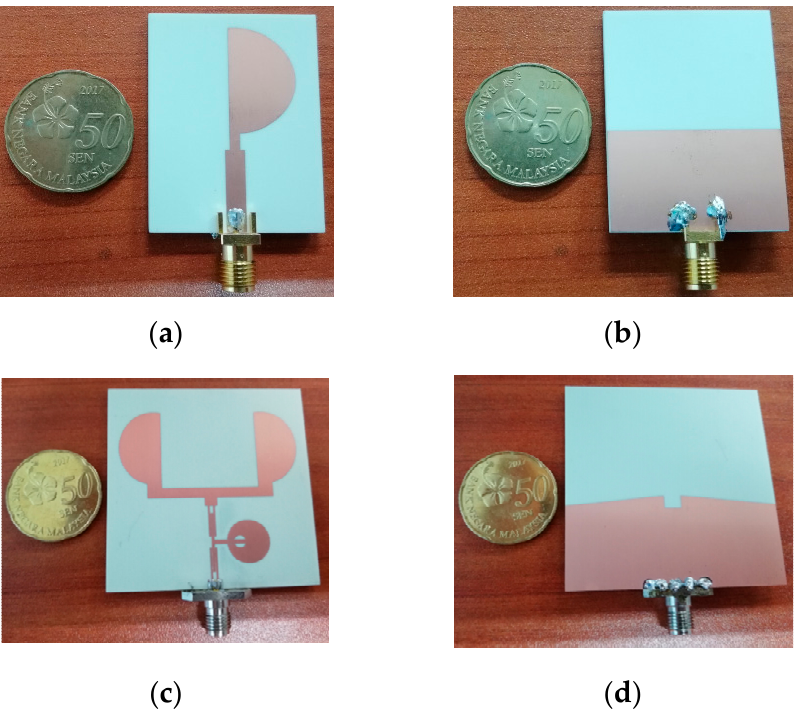
Figure 14. Photograph of the UWB antenna prototypes: ( a ) Modified UWB antenna front view, ( b ) Modified UWB antenna back view, ( c ) Modified UWB filtering antenna array front view, ( d ) Mod- ified UWB filtering antenna array back view.